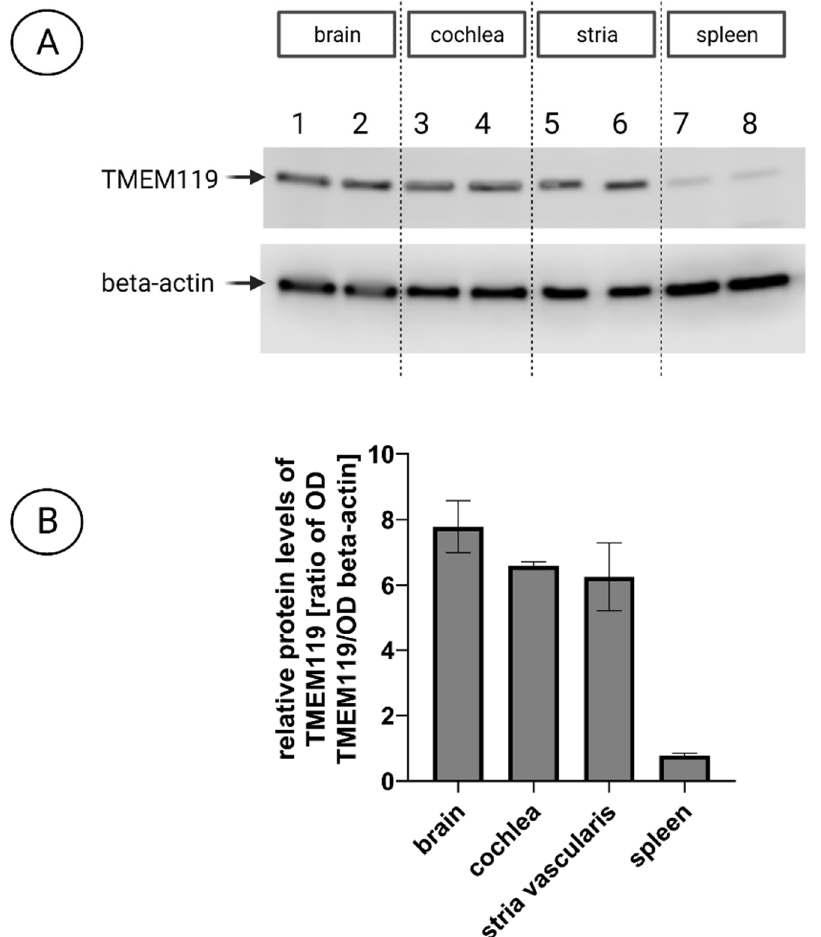
Figure 7. The levels of TMEM119 protein in the cochlea and stria vascularis of postnatal C57/Bl6J mice. ( A ) Representative Western blot (WB) images showing TMEM119 (MW 40 kDa) protein in the cochlea (lines 3 and 4) and stria vascularis explants (lines 5 and 6) compared with the brain as a positive control tissue (lines 1 and 2) and spleen as negative control (lines 7 and 8). B-actin (42 kDa) was used as a loading control for all samples; 16 µ g of protein per lane was loaded. The quantitative densitometry analysis of TMEM119 protein relative to β -actin revealed similar TMEM119 protein levels in the brain, cochlea, and stria vascularis (between 6- and 8-fold relative to β -actin). The spleen had much lower TMEM119 protein levels (approximately 1.03-fold relative to β -actin). ( B ) Relative TMEM119 levels were calculated on the basis of total protein staining intensity per line (reversible Ponceau S staining) and the optical density of bands representing β -actin and TMEM119. An independent-samples t -test determined no statistical di ff erences between the levels of TMEM119 protein in the cochlea and brain or between the cochlea and stria. There were signi fi cant di ff erences between TMEM119 levels in the spleen and brain ( p = 0.0064), spleen and stria vascularis ( p = 0.0174), and spleen and cochlea ( p = 0.0003).